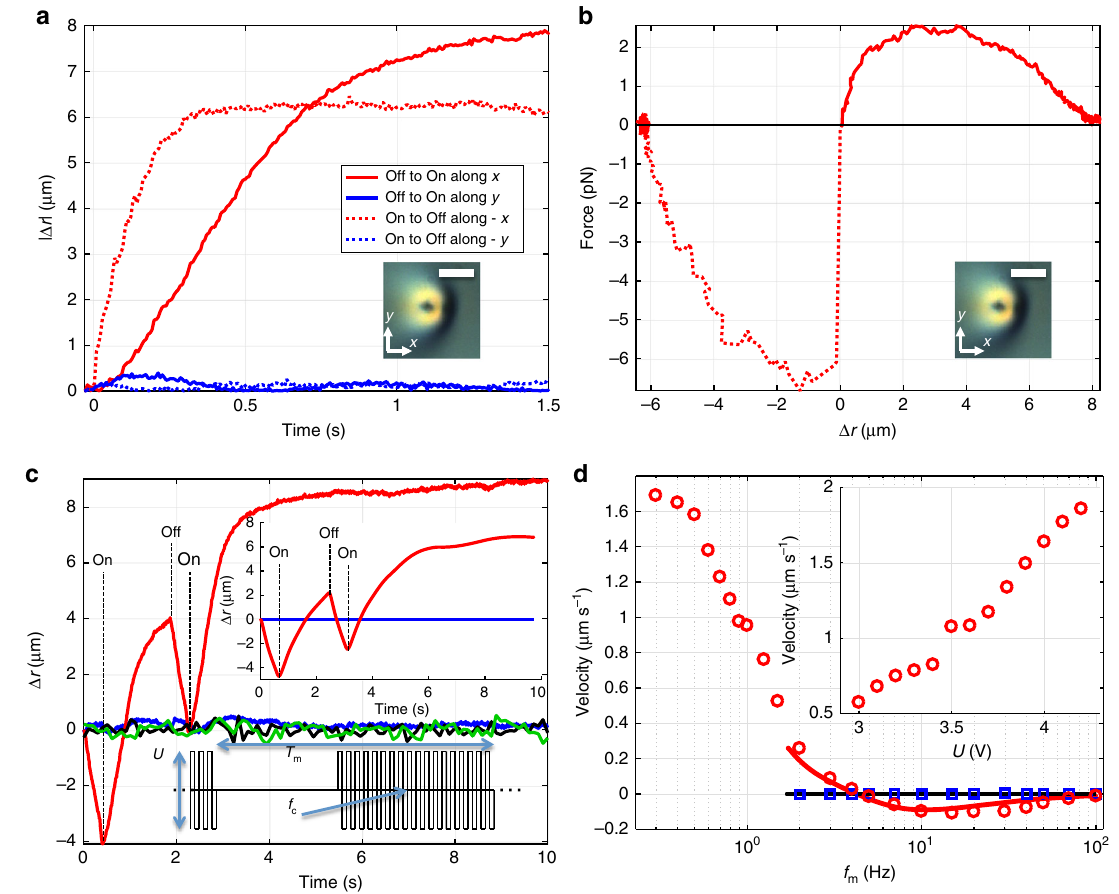
Fig. 6 Directional motion of baby skyrmions. a Relative shift of spatial position of the skyrmion ’ s south-pole preimage | Δ r | vs. time upon turning voltage U = 4 V on (solid lines, motion along positive x , y ) and off (dotted lines, motion along negative x , y ) for the x - and y -directions de fi ned in the inset and in Fig. 1c and 2f. ( b ) Corresponding forces along ± x (inset) acting on the baby skyrmion vs. Δ r . POM micrographs in the insets of ( a , b ) de fi ne the coordinate system; the scale bar in the insets is 10 µ m. c Video microscopy characterization of the directional motion of the skyrmion in response to switching of the applied voltage on and off when starting with the voltage on; the corresponding computer simulated results are shown in the top inset. The bottom inset illustrates the square waveform voltage driving with carrier frequency f c = 1 kHz and modulation period T m . The directional motion of the skyrmion along the x axis is compared to the motion of a tracer nanoparticle along the same x -axis at no fi eld (black solid line) and at an applied voltage of 4 V (green solid line) with the same voltage-driving scheme and other conditions. d Dependence of the direction and amplitude of the baby skyrmion ’ s velocity on the modulation frequency f m = 1/ T m = 0.3 – 100 Hz characterized using video microscopy for a duty cycle of 75%; the experimental data are shown using symbols and the corresponding computer-simulated dependencies within f m = 1/ T m = 2 – 100 Hz are shown using solid lines. Inset shows the skyrmion ’ s velocity vs.